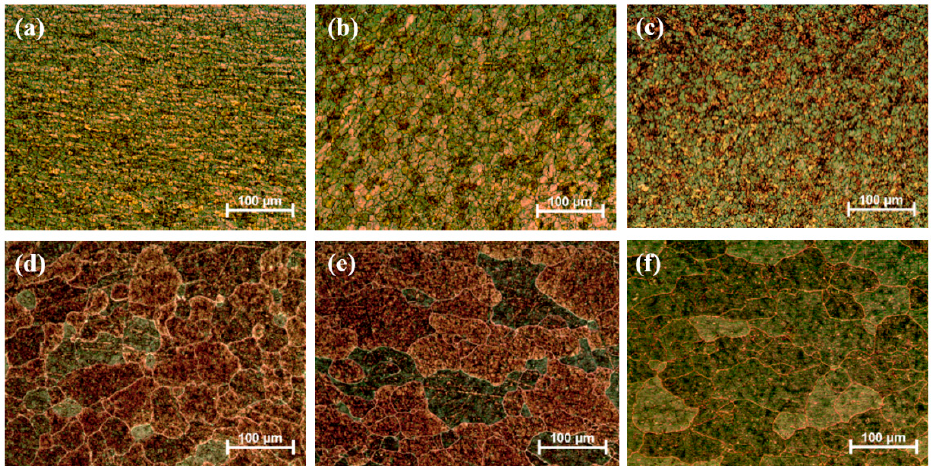
Figure 5. Microstructure of the welded sample around the nugget zone at: ( a ) Advancing side; ( b ) and retreating side for naturally aged joints made by RAFSW at optimized process parameters.